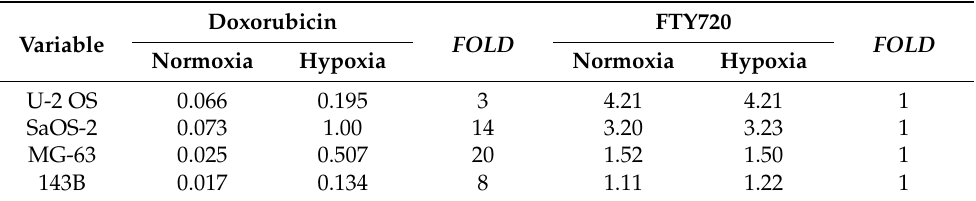
Table 2. Cytotoxicity of doxorubicin and FTY-720 on a representative panel of osteosarcoma cell lineages (GI 50 , 72 h, MTT assay).